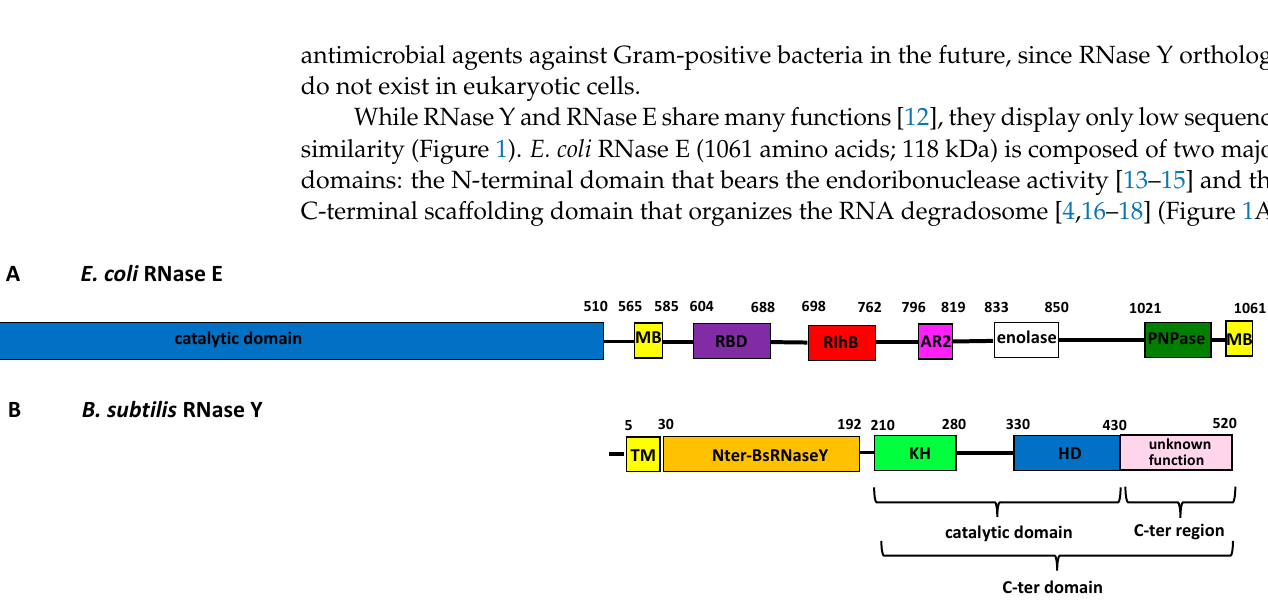
Figure 1. Comparison of the domain organization of E. coli RNase E and B. subtilis RNase Y. ( A ) Schematic representation of E. coli RNase E showing the interactions with proteins from the degradosome machinery (adapted from [19]). RBD and AR2 are arginine-rich RNA-binding domains flanking the RhlB (helicase) binding site and MB are membrane-binding domains. ( B ) Schematic representation of B. subtilis RNase Y. The catalytic domain contains KH and HD motifs. The KH homology module is a widespread RNA-binding motif, whereas the HD motif is characteristic of a superfamily of metal-dependent phosphohydrolases. TM is the transmembrane sequence. In this figure, the delimitation of the domains is based on the amino acids sequence.